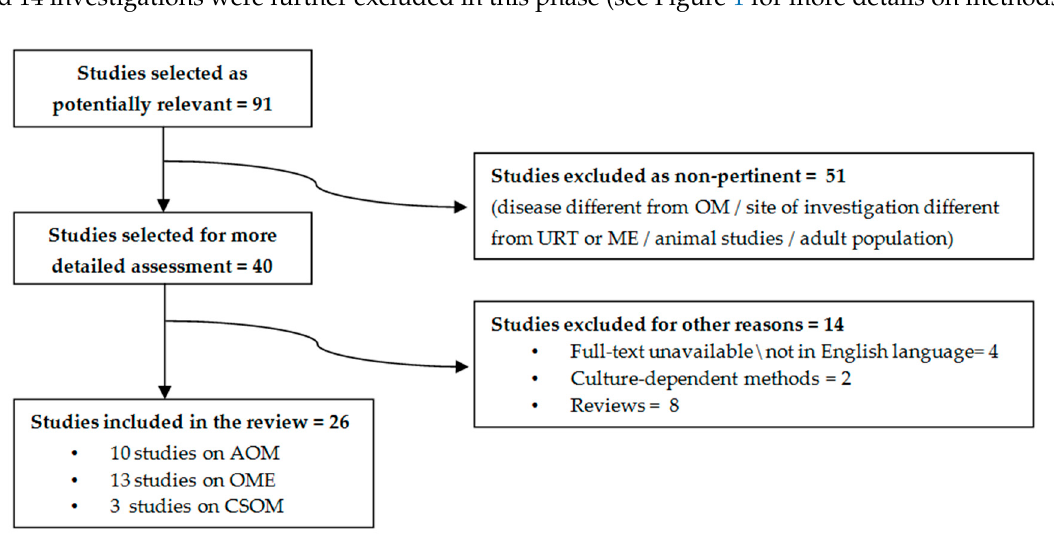
Figure 1. Search strategy conducted for this review. Legend: OM: Otitis media. AOM: Acute otitis media. OME: Otitis media with effusion. CSOM: Chronic suppurative otitis media. ME: Middle Ear. URT: Upper respiratory tract.